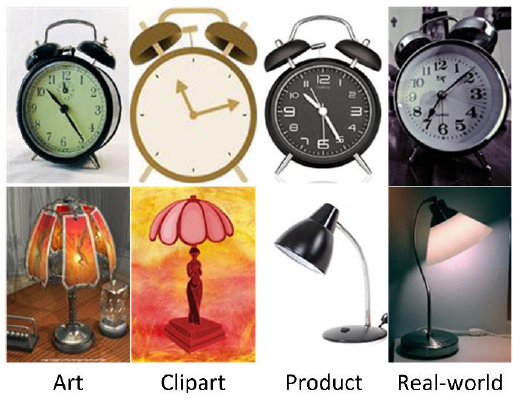
Figure 1. Samples of office – home datasets.